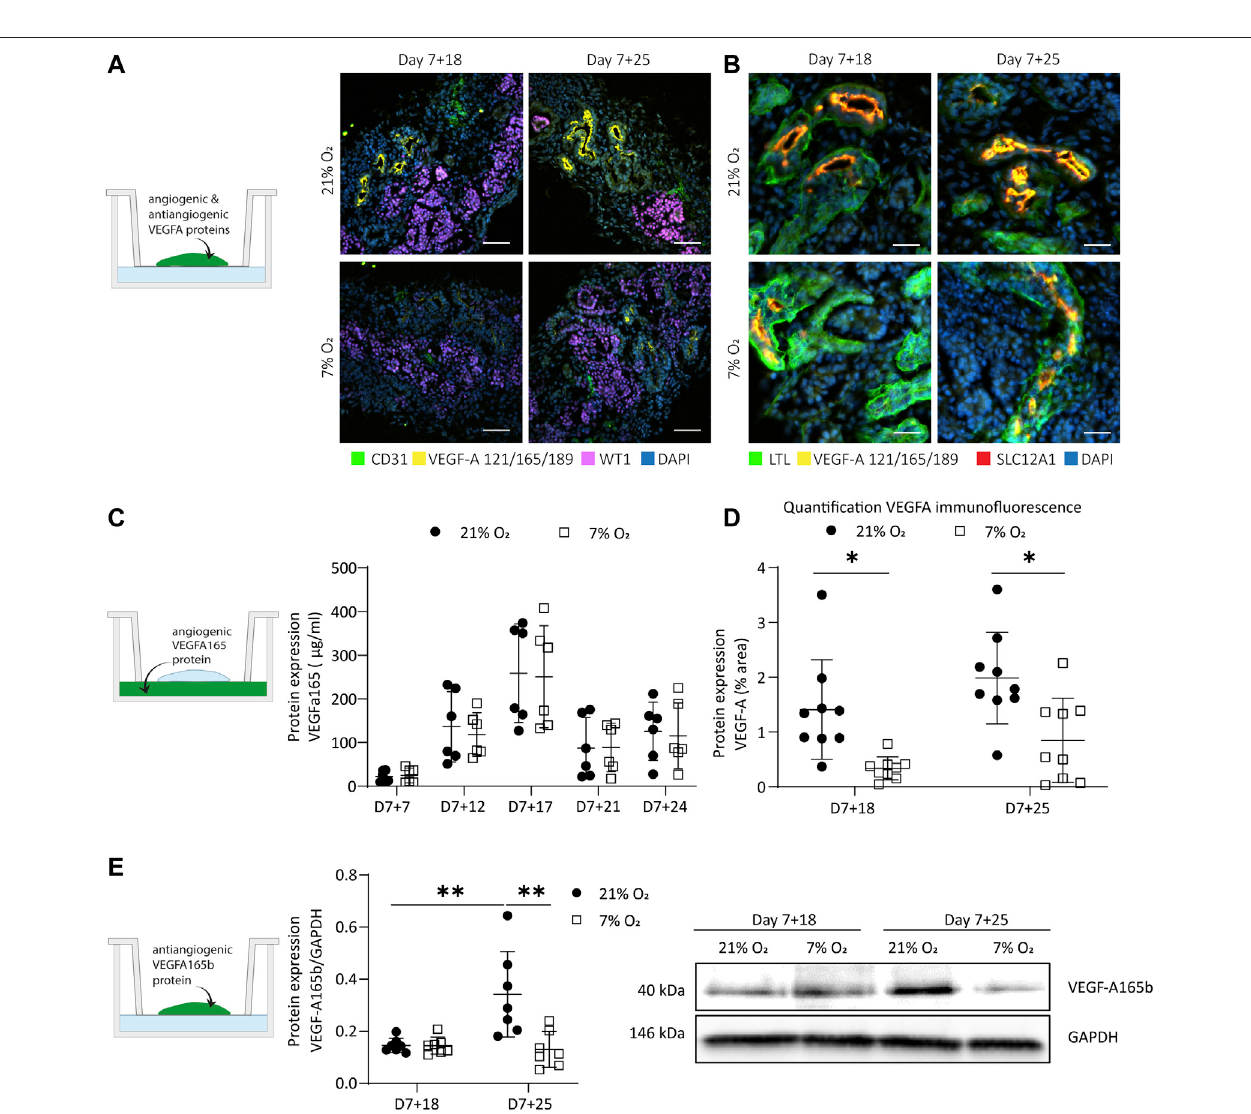
FIGURE 4 | Expression of hypoxia-responsive VEGF-A in organoids cultured in 21 and 7% O 2 . (A) . Immuno fl uorescence for VEGF-A (121, 165, 189 isoforms; yellow),endothelialcells(CD31;green),podocytes(WT1;magenta)andnuclei(DAPI;blue)displaysareductionofVEGF-Ain7%O 2 comparedto21%O 2 atbothday7+ 18 and day 7 + 25. ( n = 3, N = 3). Scale bar: 50 µm. (B) . Immuno fl uorescence shows localization of VEGF-A to the apical side of proximal tubules co-positive for loop of Henle marker (SLC12A1; red). ( n = 3, N = 3). Scale bar: 25 µm. (C) . VEGF-A165 protein expression measured in the culture medium was differentially expressed over time, but not signi fi cantly different in hypoxia compared to normoxia. ( n = 3, N = 2). (D) . Quanti fi cation of immuno fl uorescence images con fi rm that VEGF-A was signi fi cantly lower expressed in hypoxia compared to normoxia. ( n = 3, N = 3) (E) . The anti-angiogenic VEGF-A165b isoform was signi fi cantly upregulated over time in normoxia and signi fi cantly downregulated in hypoxia compared to normoxia at day 7 + 25. ( n = 2, N = 3). *= p ≤ 0.02, ** = p < 0.003.